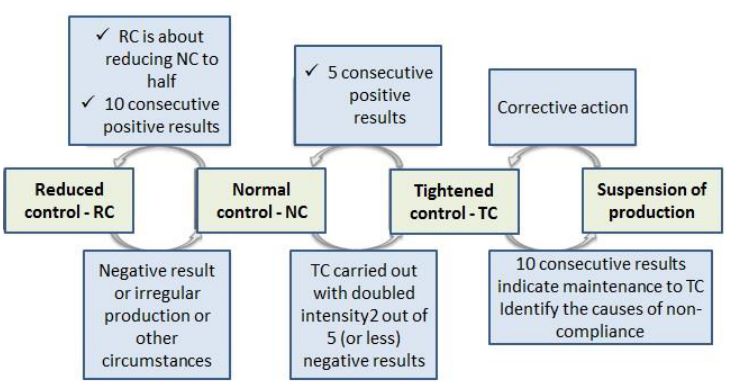
Figure 10. Conditions for the transition between the levels of strength control for precast concrete elements according to EN 13369:2018-05 [17]. elements according to EN 13369:2018-05